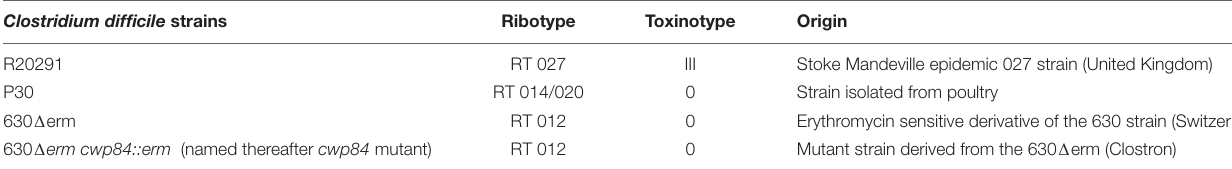
TABLE 1 | Characteristics of Clostridium difficile strains used in this